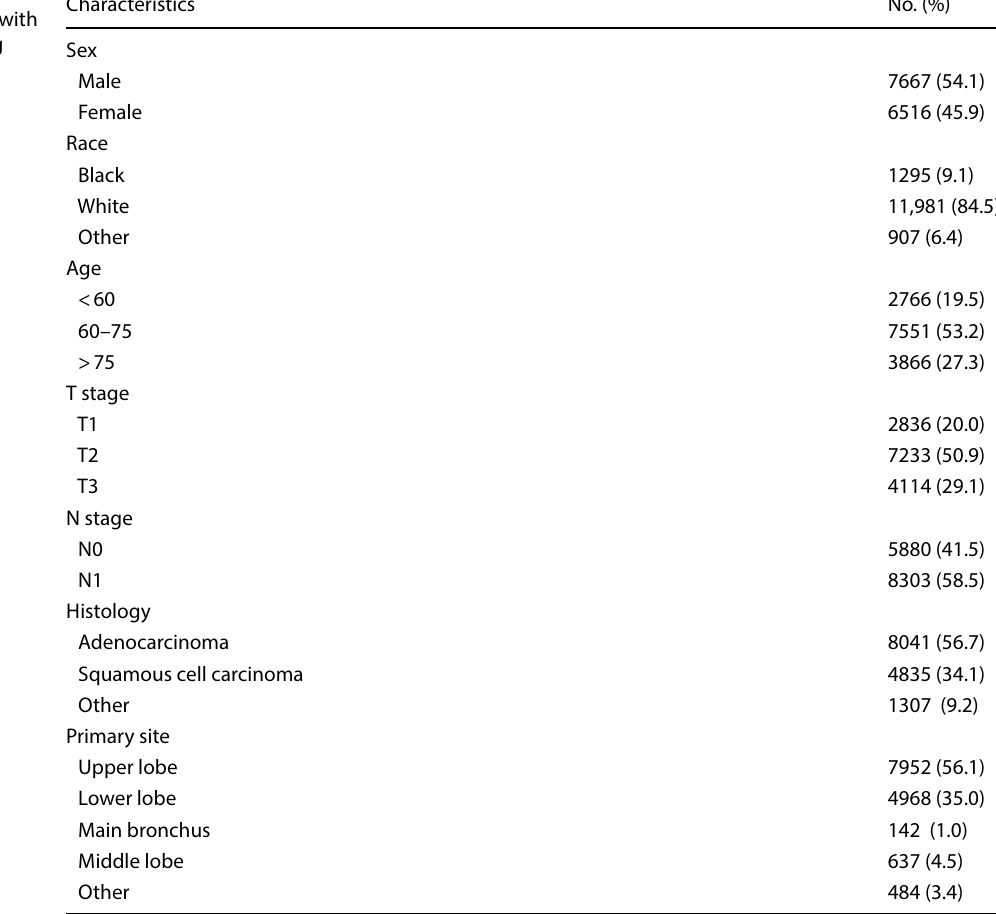
Table 1 Baseline characteristics of patients with stage II non-small cell lung